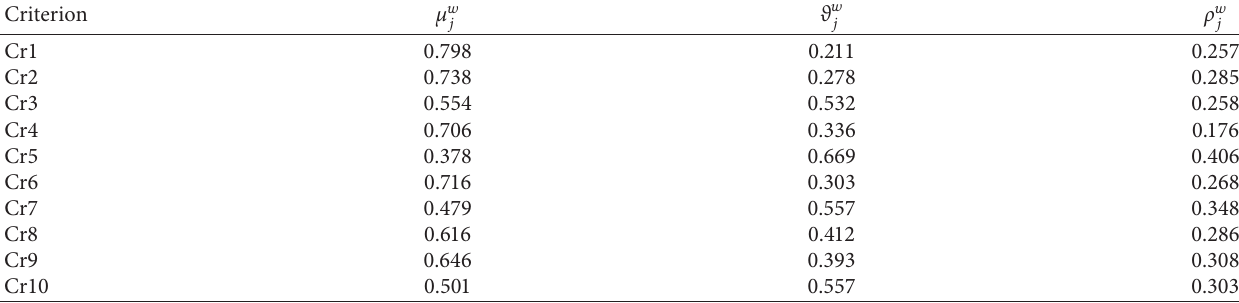
Table 3: Spherical criteria weight coefficients.